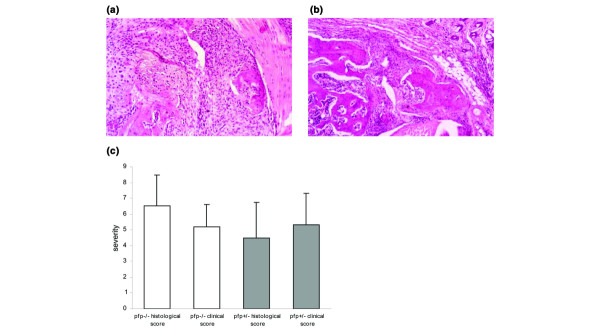
Histopathology of perforin-deficient pfp-/- mice compared with pfp+/- mice. (a) Joint of a pfp-/- mouse with severe inflammation and erosions, stage 4. (b) Paw of a heterozygous mouse in the same stage of disease. (c) Comparison of histological and clinical evaluation of the disease. Data are values of severity of pfp+/- mice (n = 6) and pfp-/- mice (n = 6), and are shown as means ± SEM.